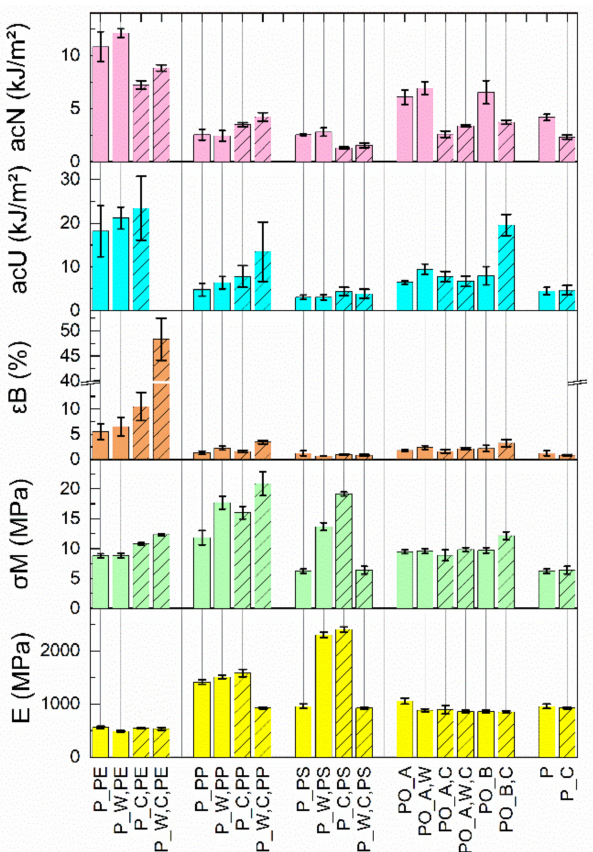
Figure 3. The results of the tensile tests (E, σ M, ε B ), the Charpy impact strength (a cU ), and the Charpy notched impact strength (a cN ) for all materials